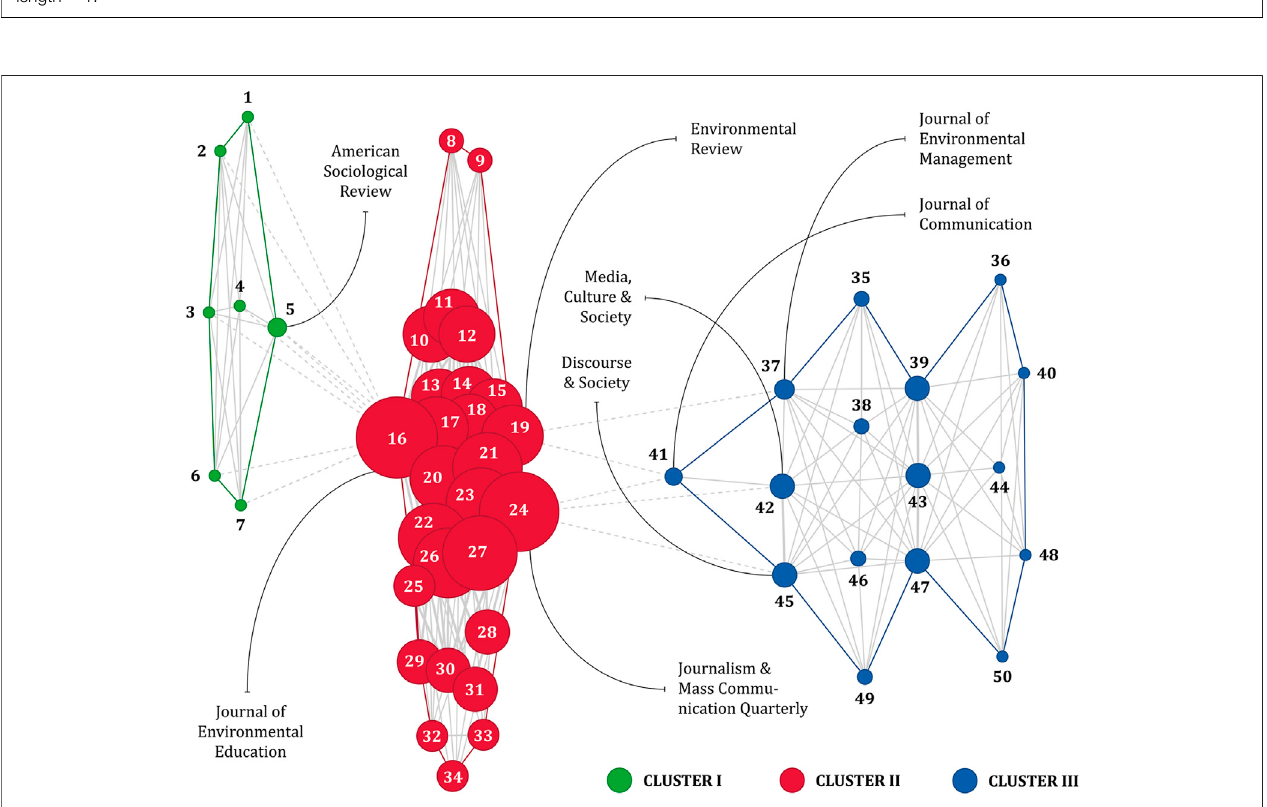
FIGURE 4 | 1990 – 1999 journal co-citation network; SWI (cid:1) 3.53; density (cid:1) 0.211; transitivity (cid:1) 0.865; diameter (cid:1) 5; degree centralization (cid:1) 0.275; average path length (cid:1) 2.32. Node numbers corresponding to the journals and their clusters are available in the Supplementary Table S3 .